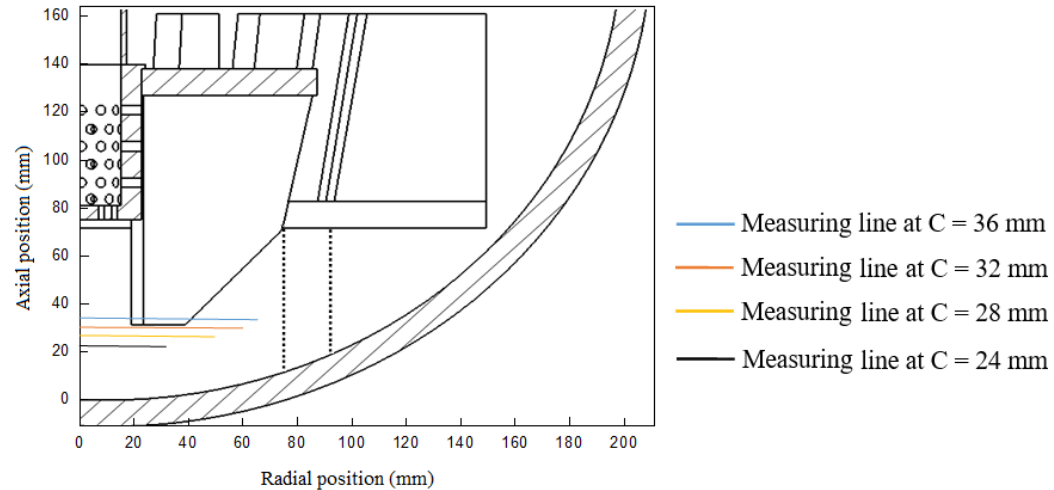
Figure 5. Coordinate diagram of the flotation tank near the bottom with D = 175 mm and C = 32 mm. Table 1. Correspondence between the axial position and the length of the measuring line segment and the impeller off-bottom clearance.